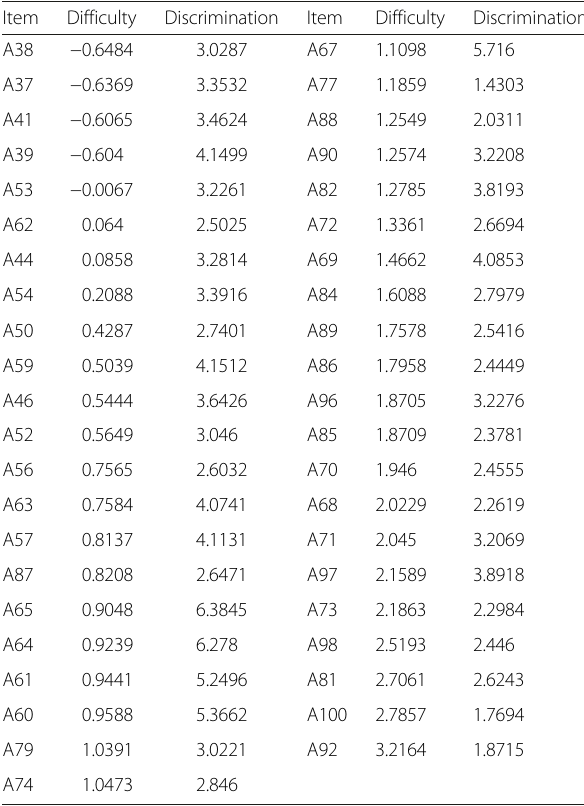
Table 4 Difficulty and discrimination power of items in version B of the